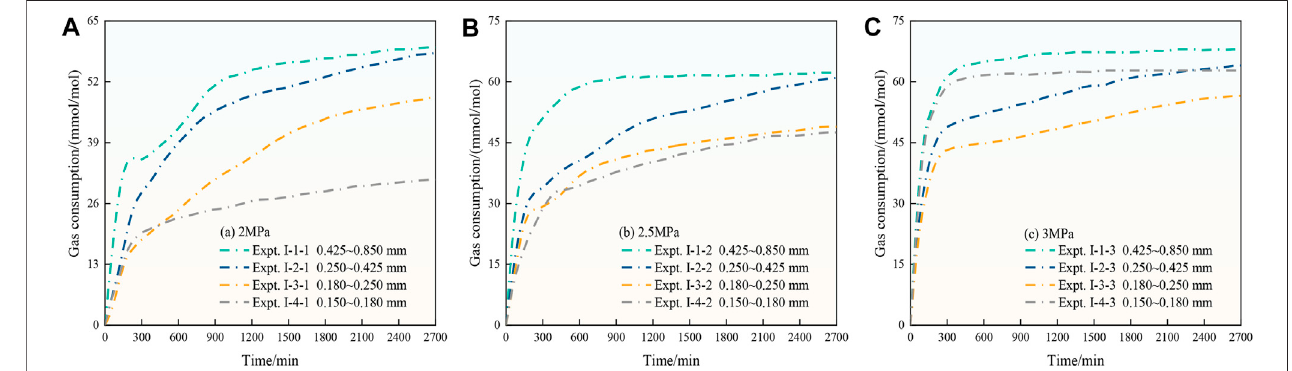
FIGURE 5 | Gas consumption of CO 2 hydrates in the 2, 2.5 and 3 MPa